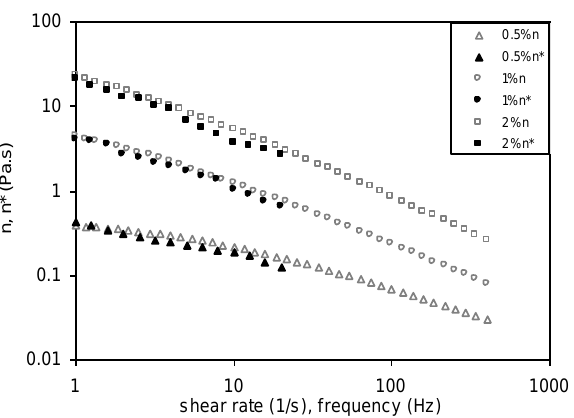
Figure 10. Cox-Merz plot of steady shear (closed symbol) and dynamic (open symbol) viscosities for